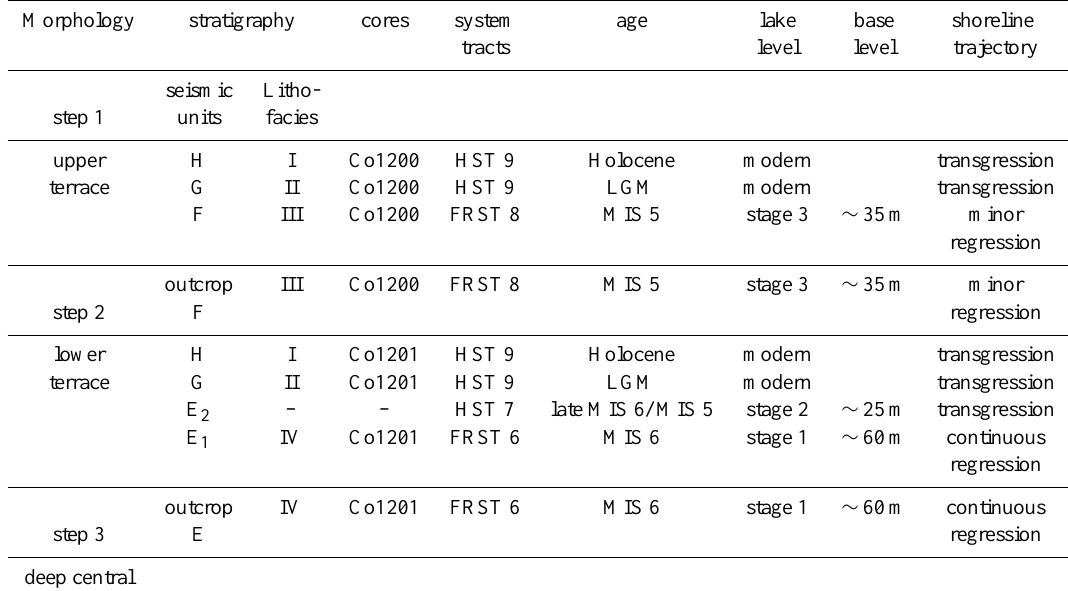
Table 3. Relationship between morphological, seismic (multichannel and sediment echosounder) and lithological data of Ohrid Bay. LGM=Last Glacial Maximum, MIS=Marine